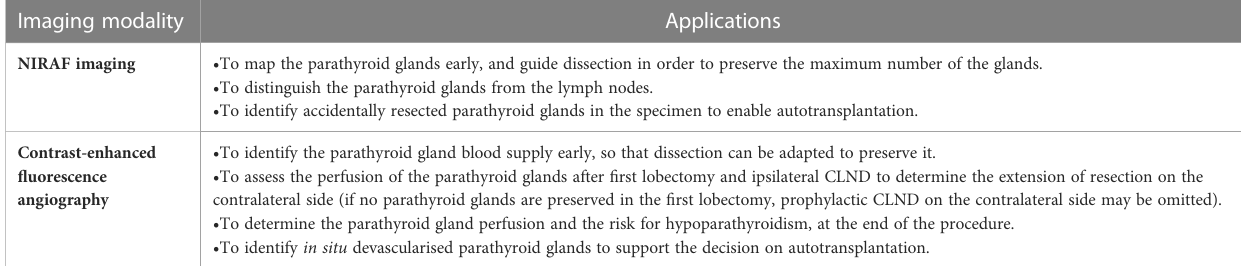
TABLE 4 Summary of applications of NIRAF imaging and contrast-enhanced fl uorescence angiography in thyroidectomy with CLND. Imaging modality Applications NIRAF